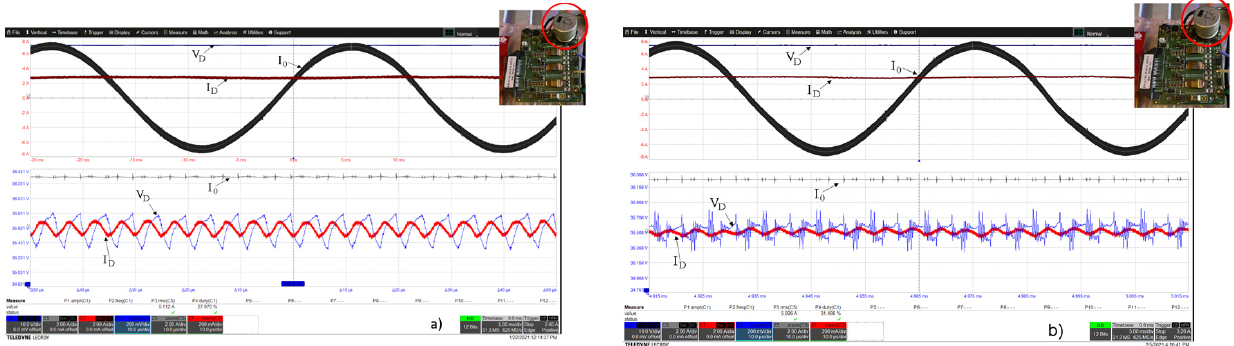
Figure 12. Switching waveform with C f = 660 µ F, dead time 21 ns at I 0 = I a = 5 A, V DC = 36 V: ( a ) 20 kHz of the switching frequency; ( b ) 100 kHz of the switching frequency. Upper waveforms V D = 10 V/div, I D = 2 A/div, I 0 = 2 A/div, t = 5 ms bottom zoomed waveforms V D = 200 mV/div, I D = 200 mA, I 0 = 2 A/div, ( a ) t = 50 ms, ( b ) t = 10 µ